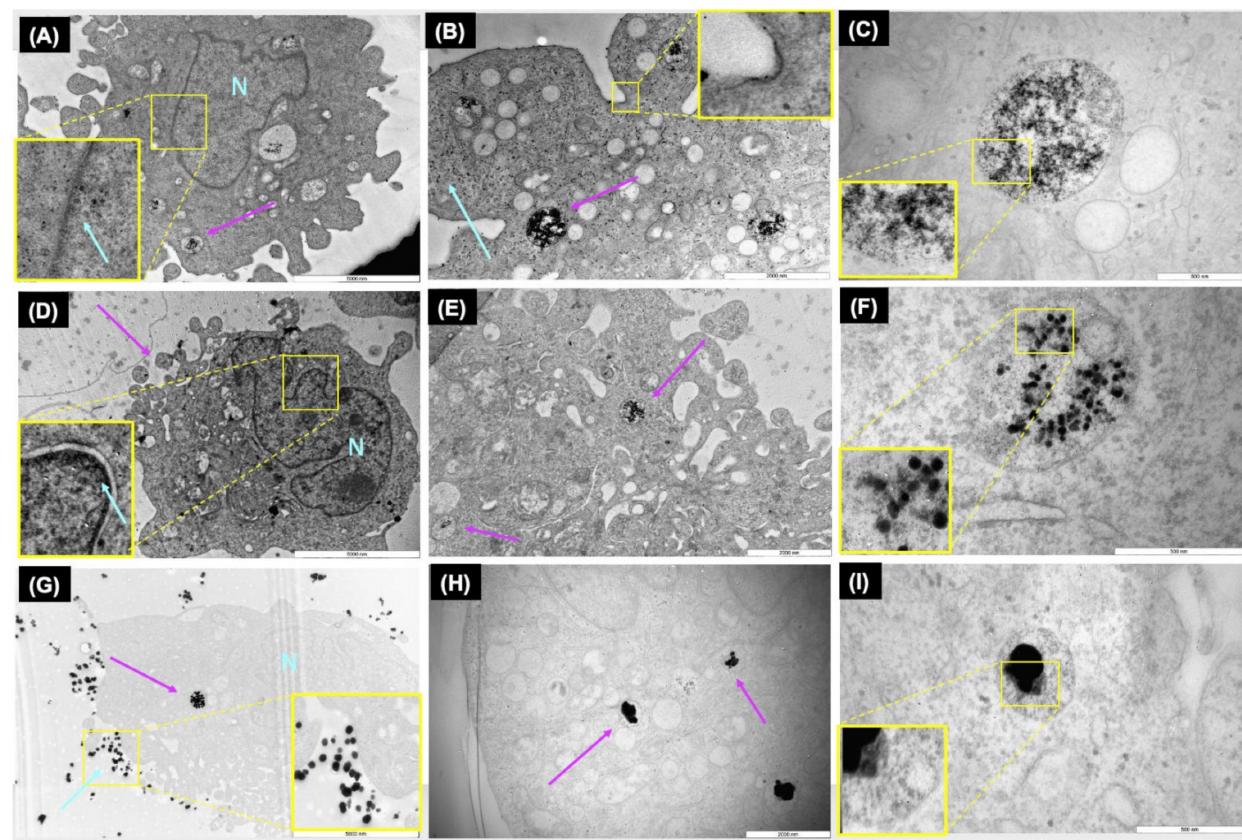
Figure 2. TEM images of intracellular AgNPs. The images show the intracellular fate of 10 µ g/mL of 10, 30, and 100 nm AgNPs. ( A – C ): uptake of 10 nm AgNPs. The yellow square in B shows an enlargement of the cell’s uptake machinery; ( D – F ): uptake of 30 nm AgNPs; and ( G – I ): uptake of 100 nm AgNPs. The scale bars correspond to 5000, 2000, and 500 nm from left to right. Purple arrows indicate the formation of vesicles in the cells, blue arrows indicate NPs in the zoomed figures (yellow squares), and N means